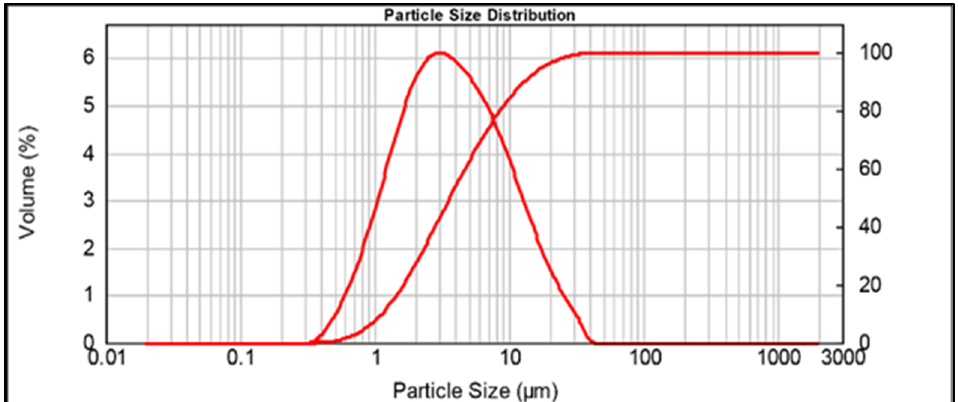
Figure 1. XRD pattern of the as-received white metakaolin powder.